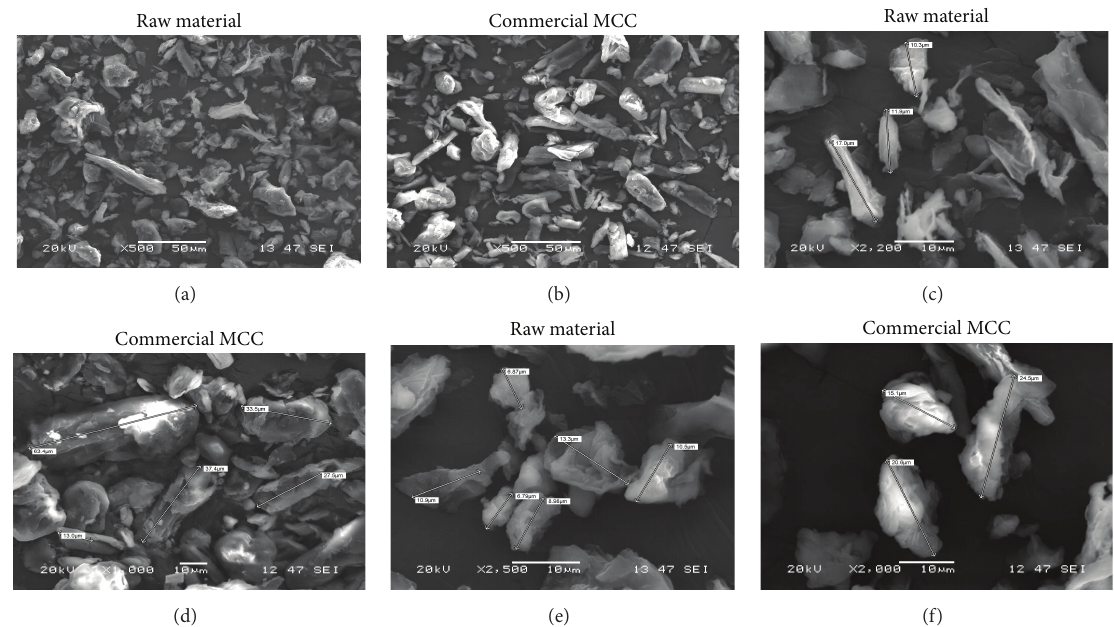
Figure 1: SEM morphological analysis of nopal cellulose microparticles (a, c, e) and commercial microcrystalline cellulose (b, d, f).